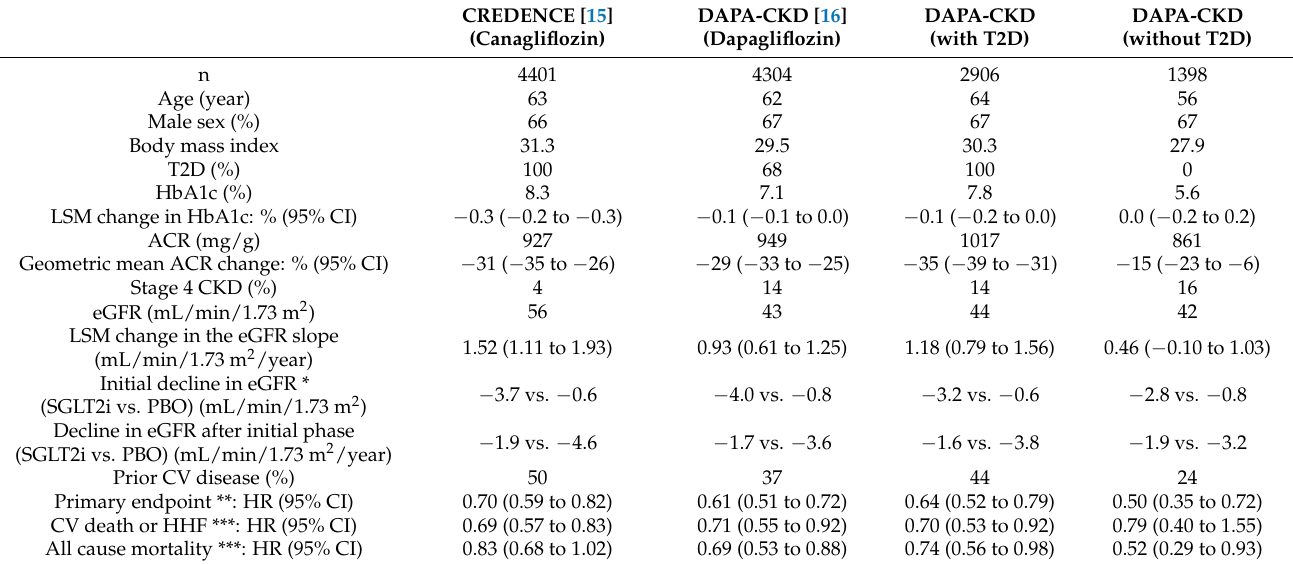
Table 1. Baseline characteristics and cardio-renal outcomes of the enrolled patients in each trial. CREDENCE [15] DAPA-CKD [16] DAPA-CKD (Canagliflozin) (Dapagliflozin) (with